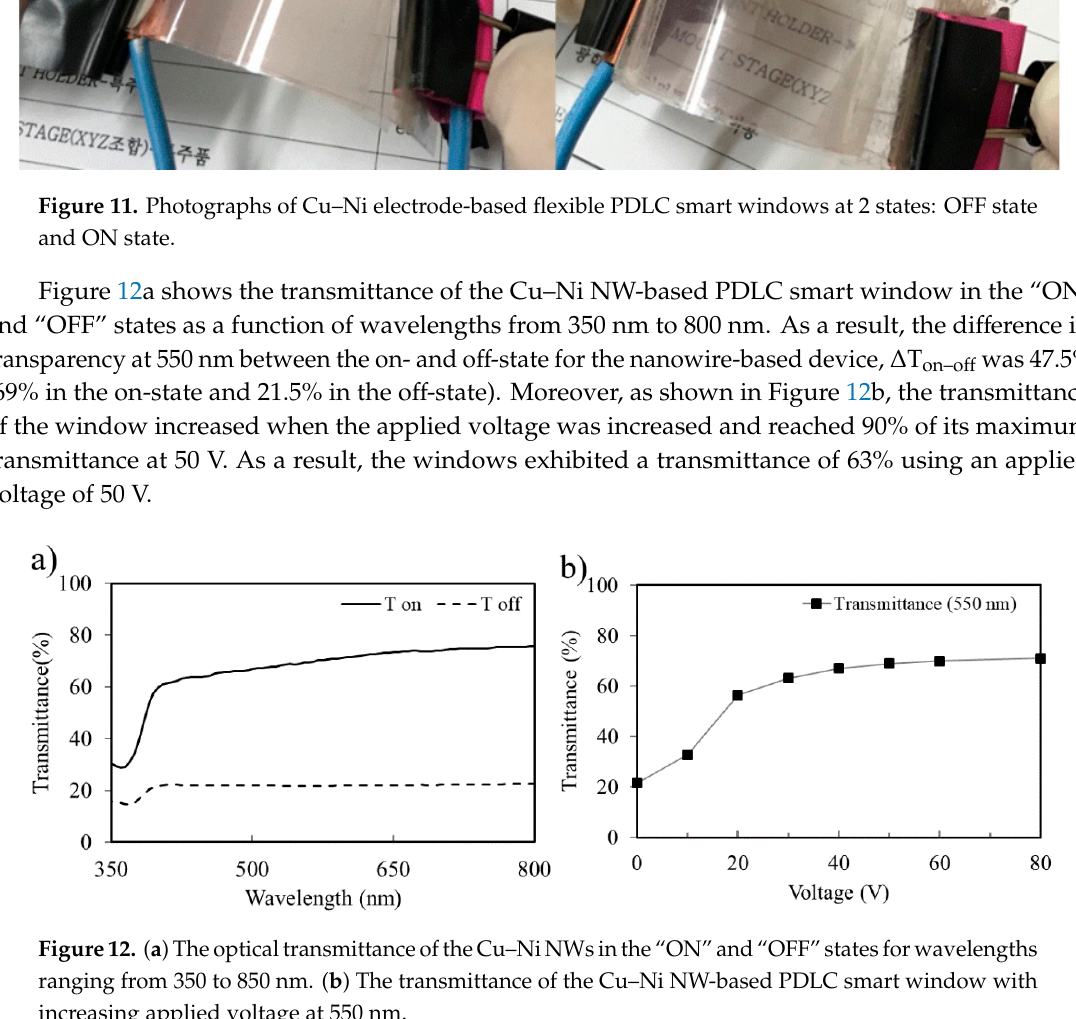
Figure 11. Photographs of Cu–Ni electrode-based flexible PDLC smart windows at 2 states: OFF state and ON state.